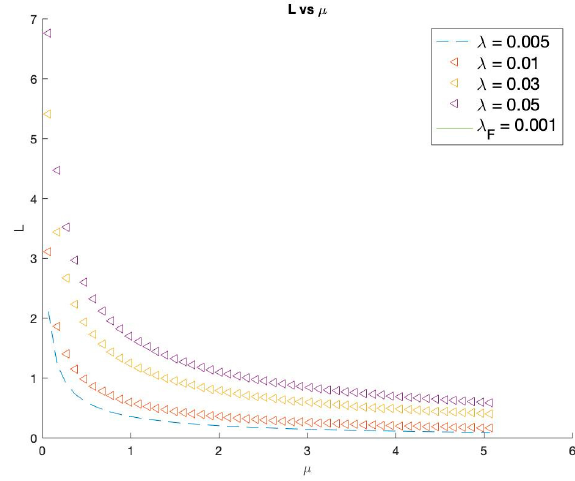
Figure 2. Average number of customers in the system ( L ) vs rate of slots ( µ ).